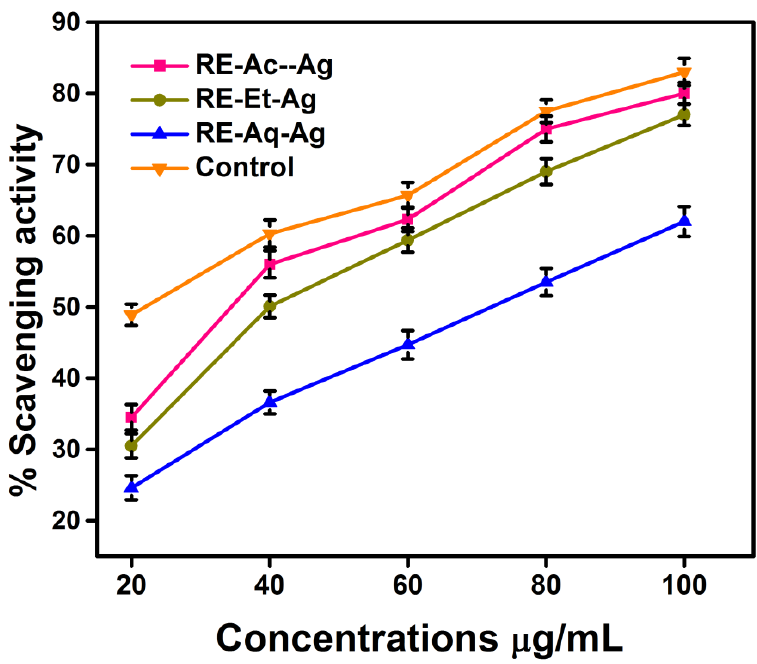
Figure 9. DPPH radical scavenging activity prepared AgNPs (values with mean + SD, n = 3).